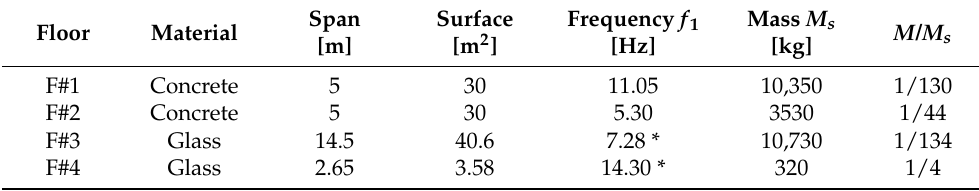
Table 1. Summary of basic features for the examined floor configurations (with M = 80